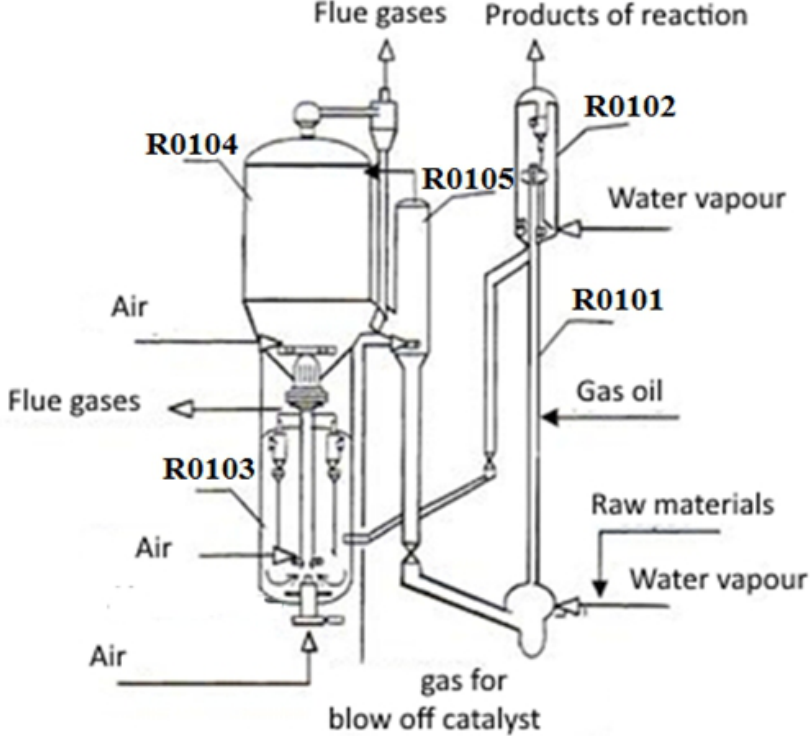
Figure 3. Scheme of reactor block of a Fluid Catalytic Cracking (FCC) R-2-R unit: